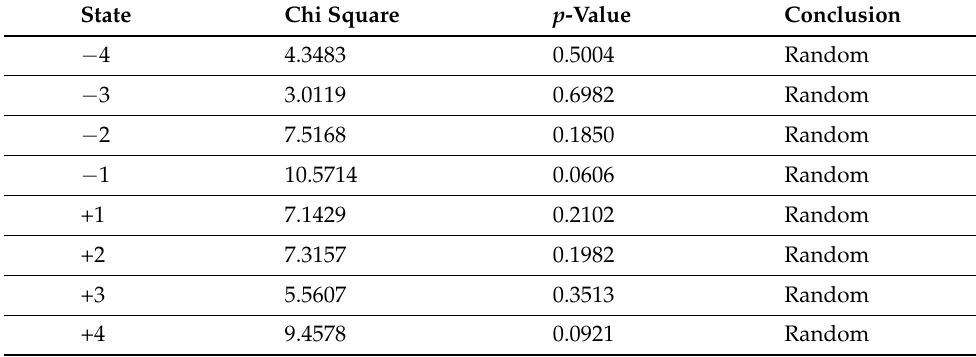
Table 4. NIST random excursion test for sequence ( w 1 n ) n ≥ 0 given by (16).